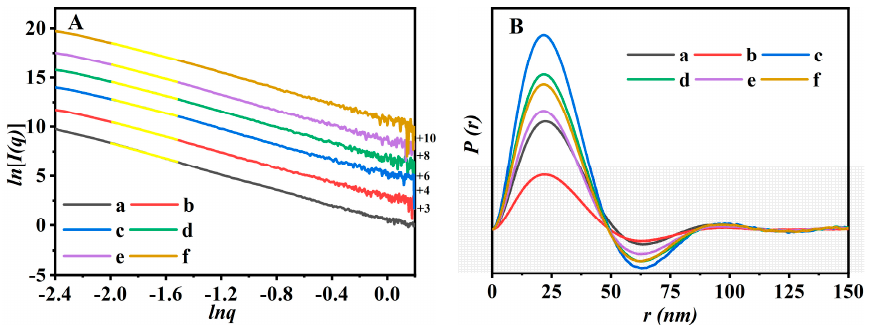
Figure 6. SAXS patterns ( A ) and their pair distance distribution function (PDDF) profiles ( B ) of CP (a), Fe(0.03) − H(0.05) − CP − 7 (e), and Fe(0.03) − H(0.05) − CP − 9